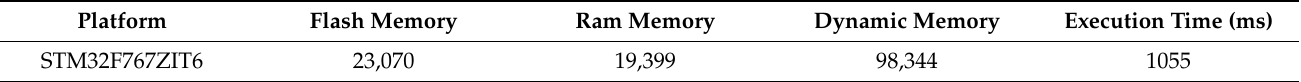
Table 3. Profiling results for 64 samples 0-Dimensional Homology Analysis. The memory is in bytes. The Dynamic Memory field represents the maximum amount of memory used by an iteration. The table is ordered by execution